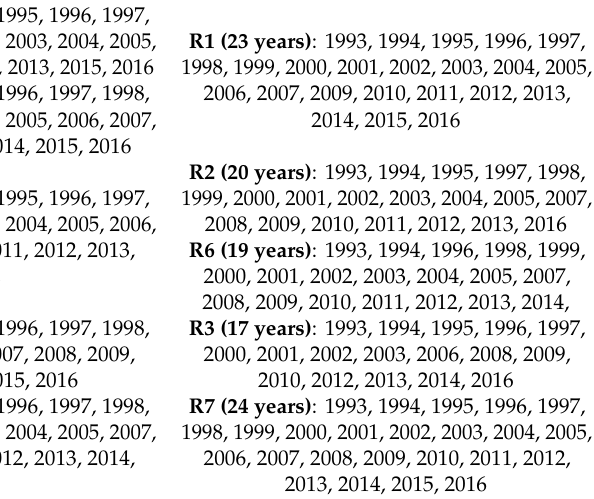
CE Mobile channel R: cycle years